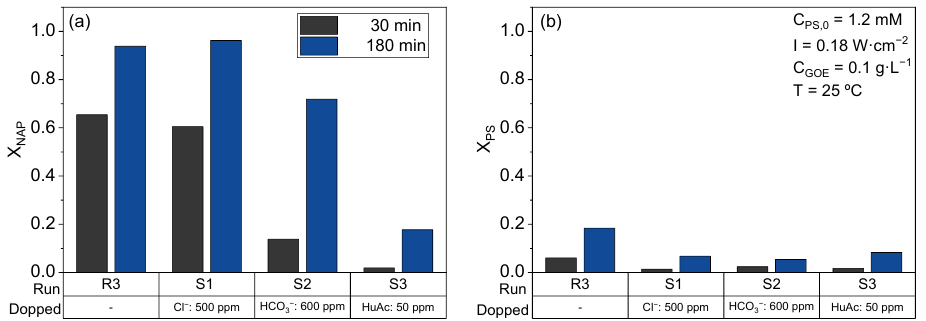
Figure 4. Effect of PS concentration in ( a ) conversion of the NAP; ( b ) conversion of PS at 30 min and 180 min. C NAP,0 = 0.1 mM, I = 0.18 W · cm − 2 , C GOE = 0.1 g · L − 1 · cm 2 and 25 ◦ C.